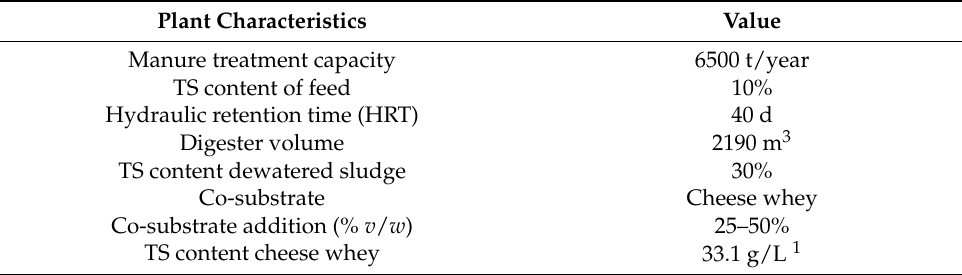
Table 1. Characteristics of the digestion treatment plant. Plant